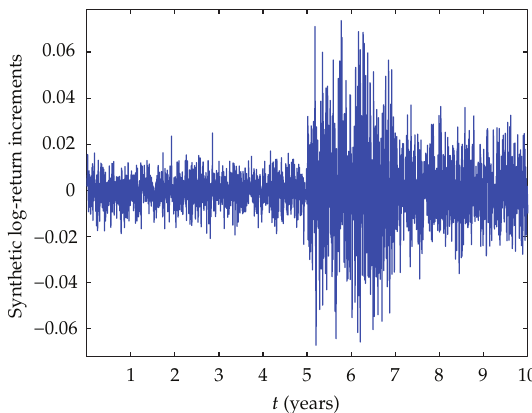
Figure 1: The daily log return increments (cid:2) synthetic data (cid:3)